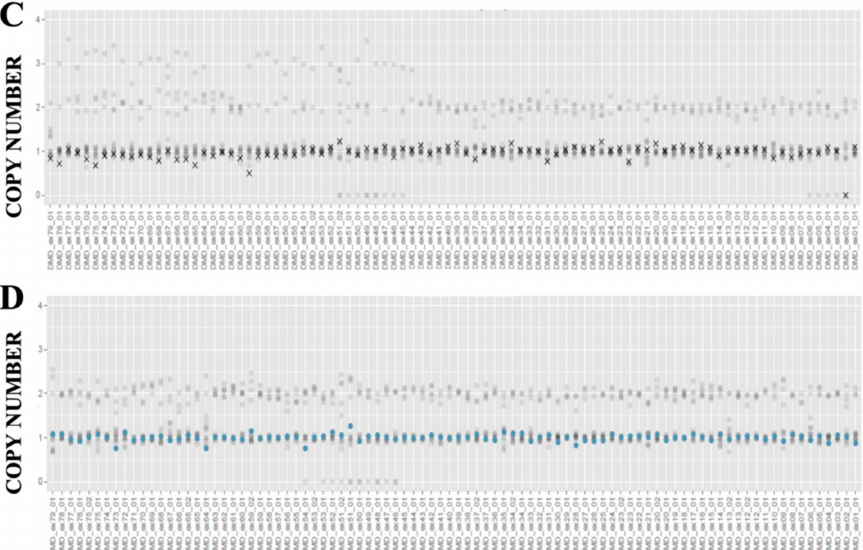
Figure 3. Examples of NGS-based CNV detection in DMD by Sophia Genetics Software. ( A , B ) Plots illustrate the presence of duplicated ( A ) or deleted ( B ) amplicons highlighted in red rectangles. ( C ) The panel displays a rejected sample for which despite the crosses along the entire gene, it is pos- sible to notice the presence of a potential deletion at the end of the line (corresponding to the exon 2); ( D ) representation of the normal profile (blue dots indicate exons without CNVs) of a male with no GRs. The horizontal axis shows the exons (from exon 1 to the right, to exon 79 to the left) and the vertical axis the copy number value. CNV, copy number variation; GR, genomic